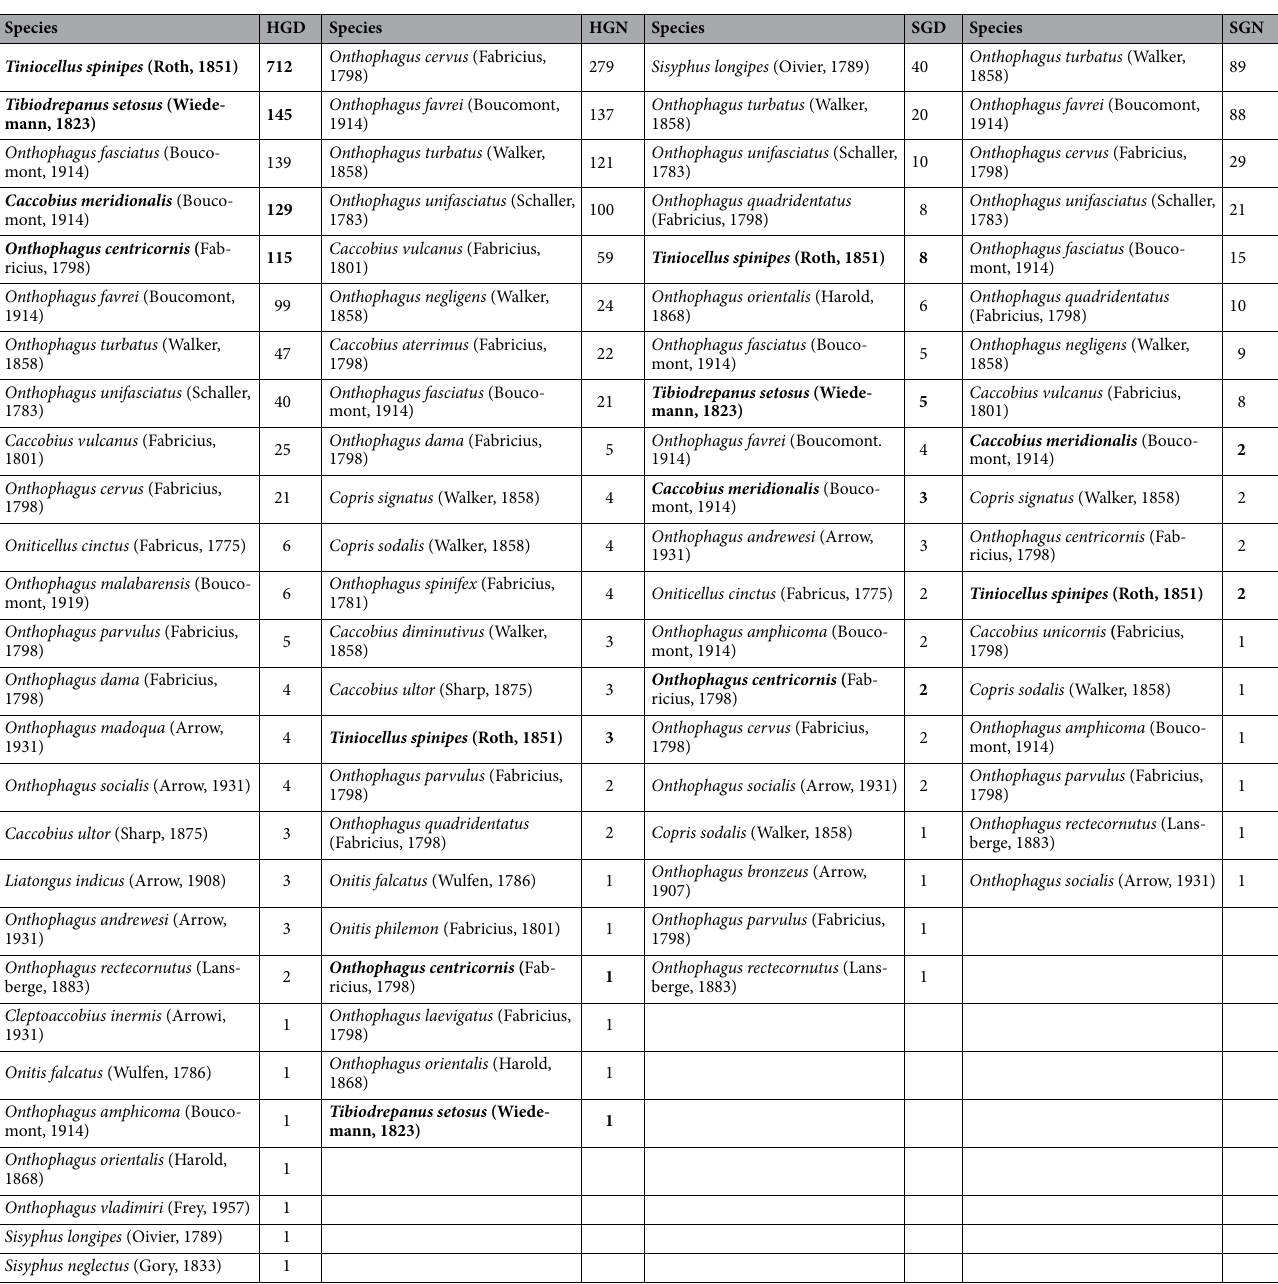
Table 2. Rank abundance of dung beetles in open (HG) and closed (SG) habitats over diel periods. The bolded are some species that showed contrast activities across habitats and by the diel periods. HGD home garden diurnal, HGN home garden nocturnal, SGD sacred grove diurnal, SGN sacred grove